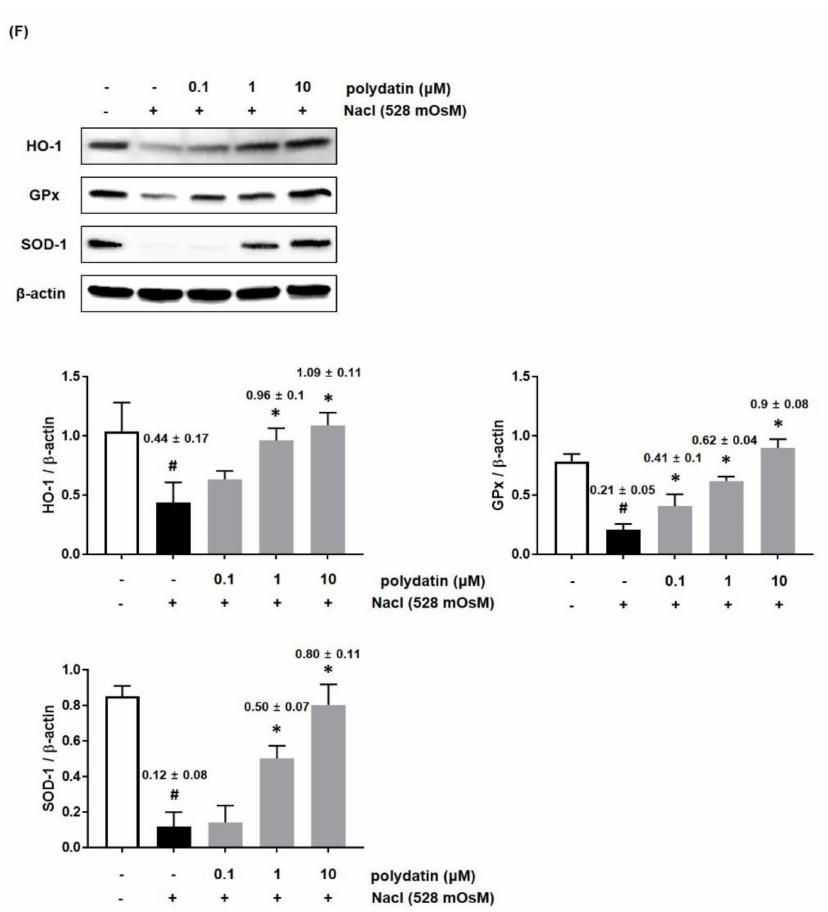
Figure 8. E ff ects of polydatin on reactive oxygen species (ROS) production in